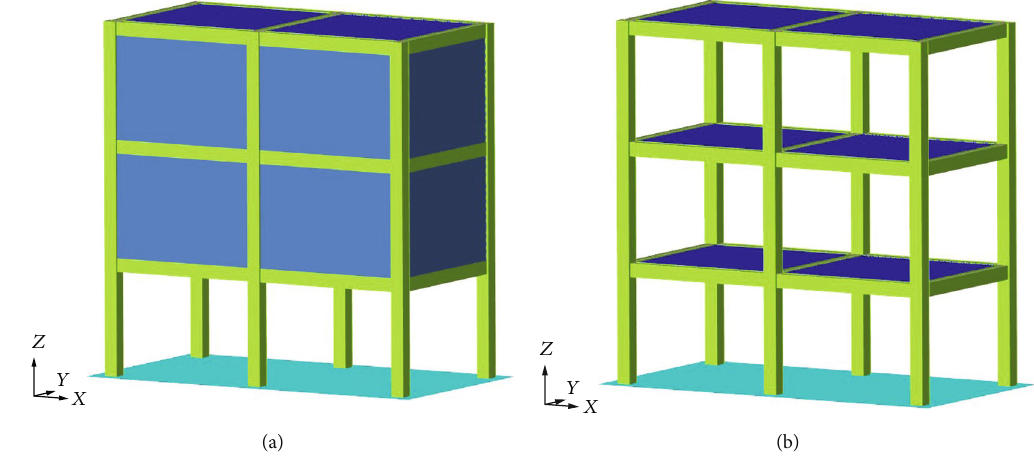
Figure 1: Reinforced concrete frame structure. (a) With masonry in fi ll walls. (b) Without masonry in fi ll